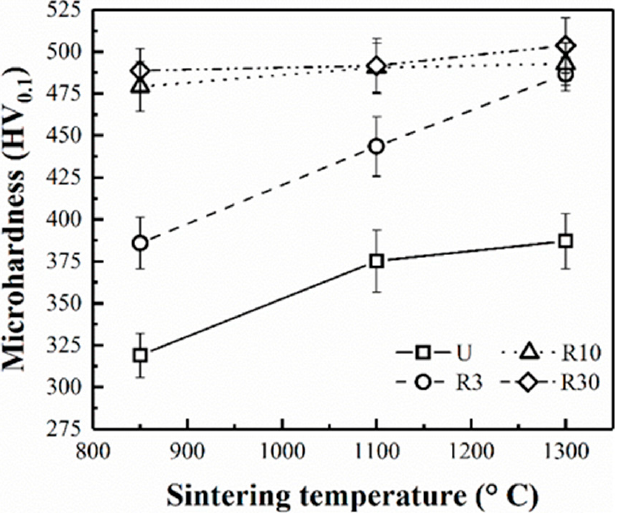
Figure 7. Microhardness Vickers versus sintering temperature for the set of experimental conditions. Characteristic indentation load-depth nanoindentation curves for the U-c and R-c sam- ples, using a maximum indentation load of 50 mN are depicted in Figure 8. The elastoplastic properties of the U and R samples, such as nanohardness ( H ) and reduced Elastic modulus ( E ) were determined by analyzing the indentation load-depth data according to the Oliver r and Pharr procedure [32]; results are summarized in Table 2. The nano hardness values of the U samples increased up to 22.53% using the higher sintering temperature (1300 ◦ C), regarding the values of the sample sintered at 850 ◦ C (similar behavior as compared with Figure 7). This improvement can be attributed to the formation of pure TiB single crystals in the titanium matrix [26]. Compared with the U samples, nano hardness values for the R-a and R-c samples were improved as an effect of the addition of the TiB 2 particles. Increments of 13% and 6% were attained for the R3-a and the R30-c samples, respectively. Clearly, the content of the reinforcement particles and secondary phases contribute to the hardening effect.